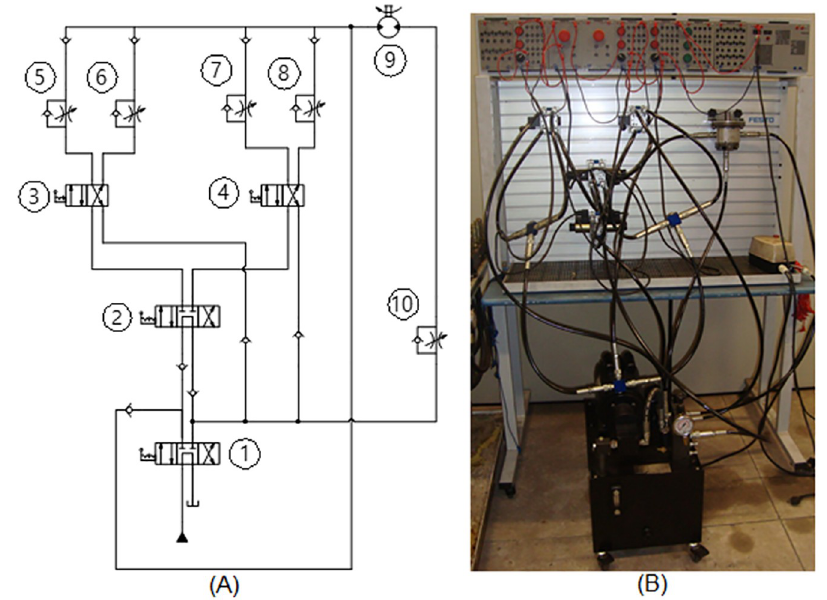
Fig 3. Schematics of the operation of the electrohydraulic system used in the test (a), and electrohydraulic circuit for simulating different rotations (b). (1 and 2): 4/3 way directional valve 5, 6, 7, 8; (3 and 4): 4/2 way directional valve; (9): Hydraulic motor and (10): Flow Regulating